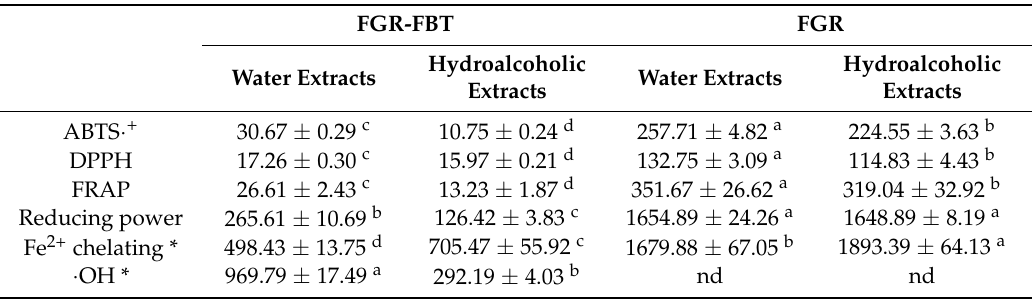
Table 3. IC 50 values in antioxidant properties of water and hydroalcoholic extracts (80% ethanol extracts) of fermented glutinous rice with Fu brick tea (FGR-FBT) and traditional fermented glutinous rice